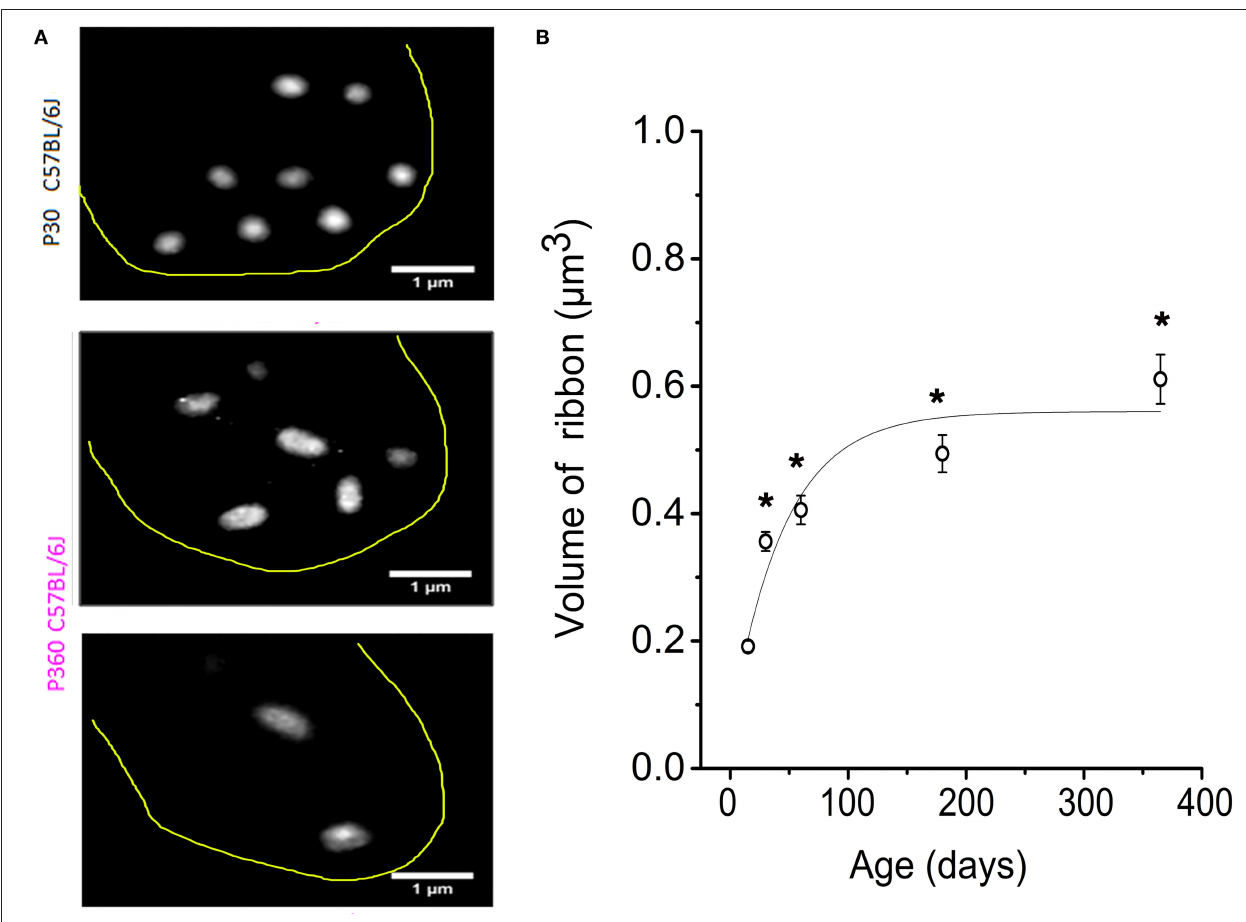
FIGURE 3 | IHC synaptic ribbons progressively increased in size with aging. (A) Example of high magnification confocal STED images (stack reconstruction of five 0.25 µ m slices). The yellow line delineates the IHC contour. Ribbons were less numerous and larger in size in IHCs from P365 C57BL/6J mice. (B) The mean volume of the IHC synaptic ribbons was calculated in the mid-cochlear region (encoding 8–16kHz), using the plugin 3D-Object counter of ImageJ, and was plotted as a function of age: P15 (203 ribbons–40 IHCs–3 mice), P30 (306 ribbons–98 IHCs–5 mice), P60 (306 ribbons–95 IHCs–3 mice), P180 (306 ribbons–67 IHCs–3 mice), P365 (295 ribbons–43 IHCs–3 mice). As indicated by the asterisks, when comparing with P15, the mean volume of the ribbons started significantly to increase significantly from P30 ( p < 0.05; one-way